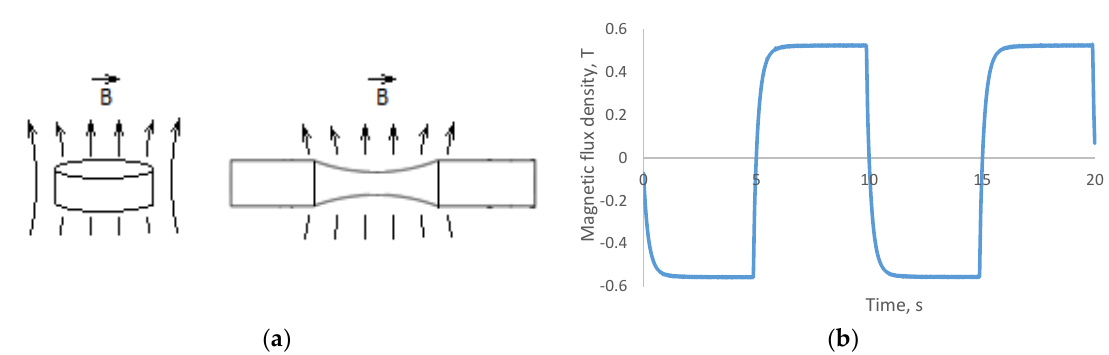
Figure 1. Scheme of treatment for samples ( a ) and the magnitude of the magnetic field during treatment ( b ).